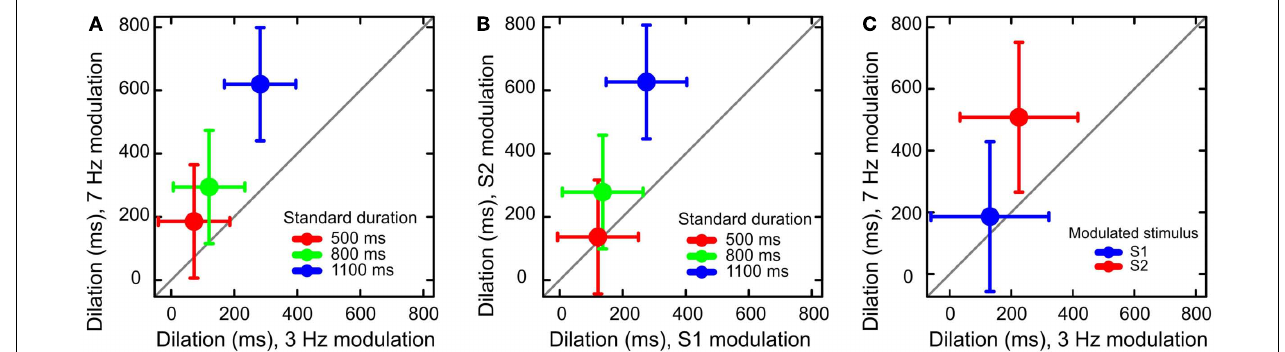
modulated: a manifestation of the time-order effect. (C) The effect of modulation frequency was larger for the higher frequency of modulation. Error bars represent 95% confidence intervals around the mean.